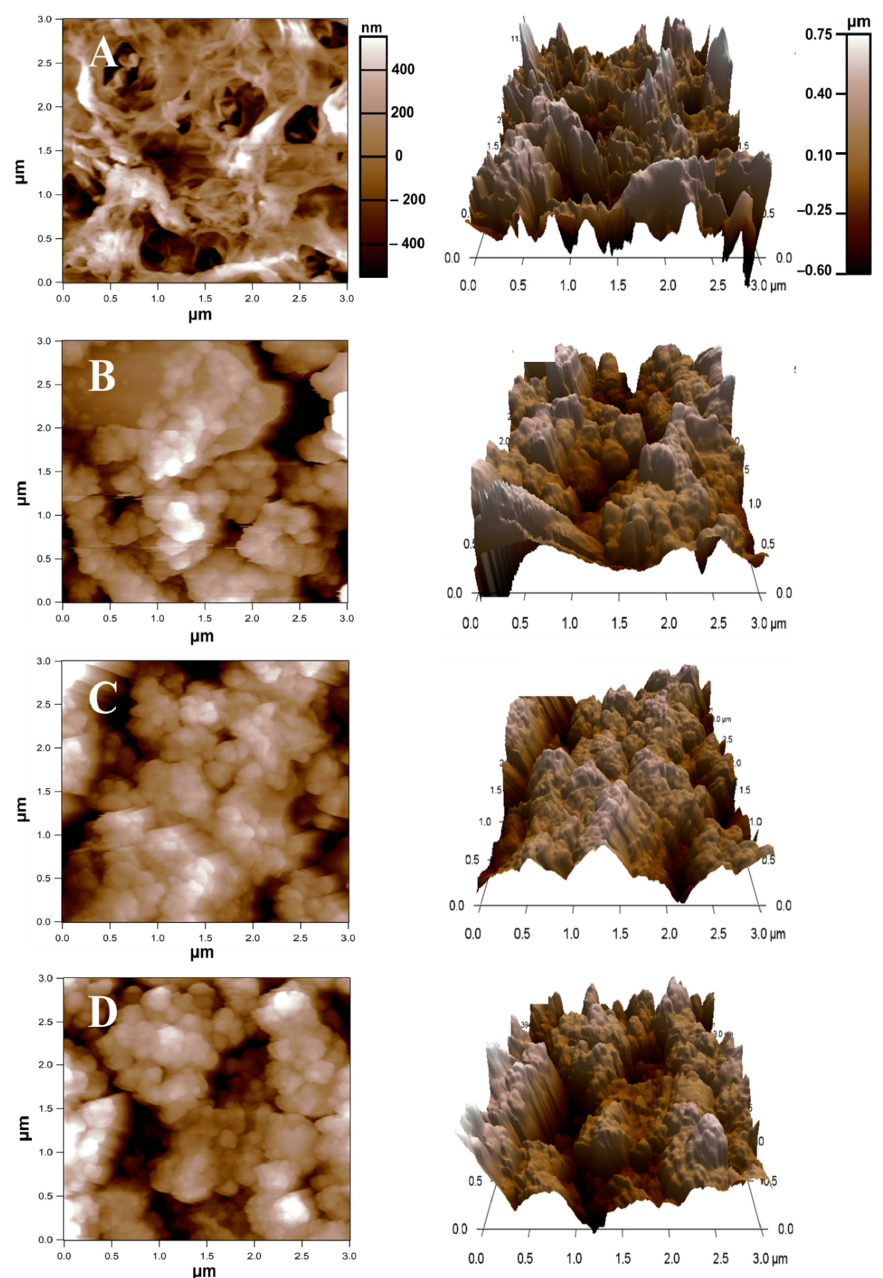
Figure 4. Two- and three-dimensional atomic force microscopy (AFM) images of ( A ) the pristine NF Figure 4. Two ‐ and three ‐ dimensional atomic force microscopy (AFM) images of ( A ) the pristine NF membrane, and the composite membranes with UiO ‐ 66_GO loadings of ( B ) 5%, ( C ) 10%, and ( D ) membrane, and the composite membranes with UiO-66_GO loadings of ( B ) 5%, ( C ) 10%, and ( D ) 15%.